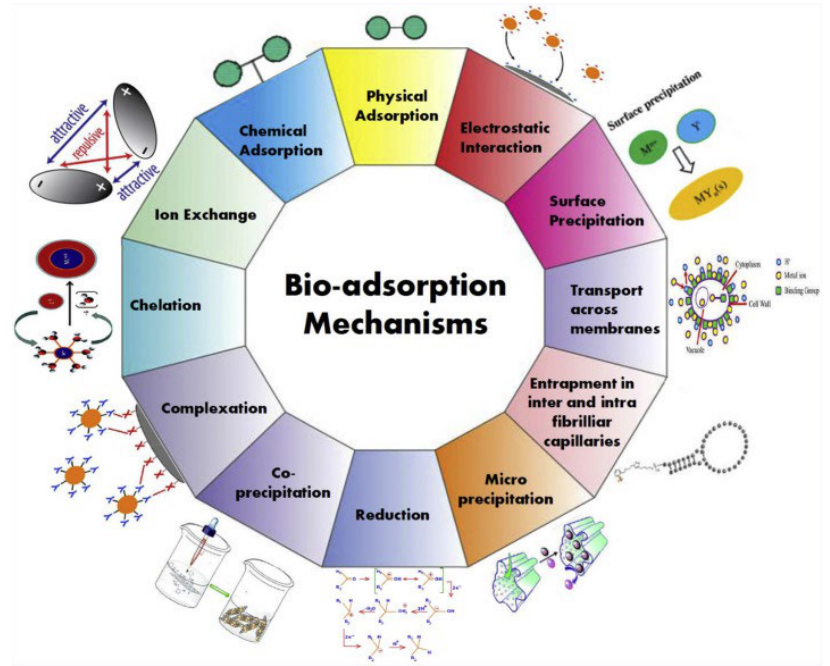
Figure 1. General mechanisms for heavy metal biosorption, adapted with permission from